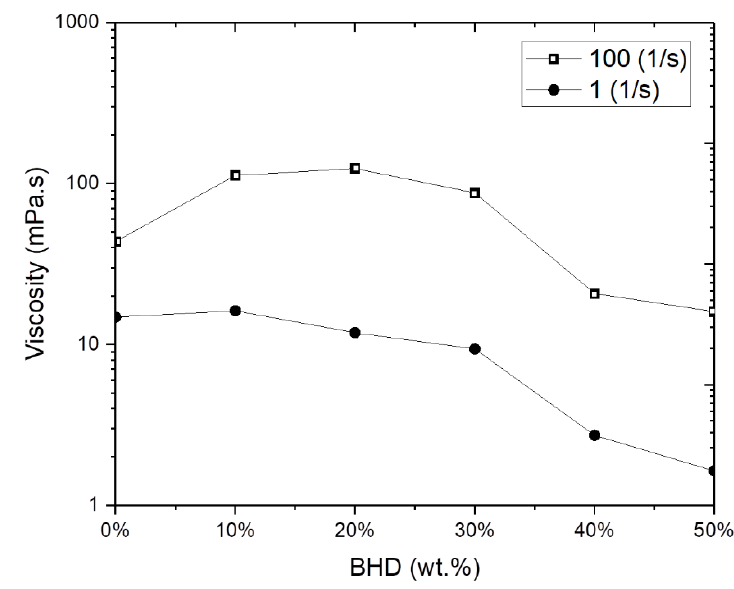
Figure 7. Effect of steel dust addition on viscosity at 1 s − 1 & 100 s − 1 .